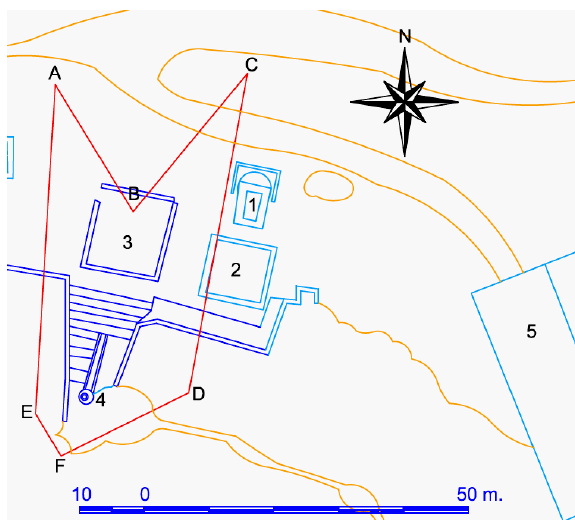
Figure 3: Sketch of premises and the traverse carried out (source: prepared by the authors)